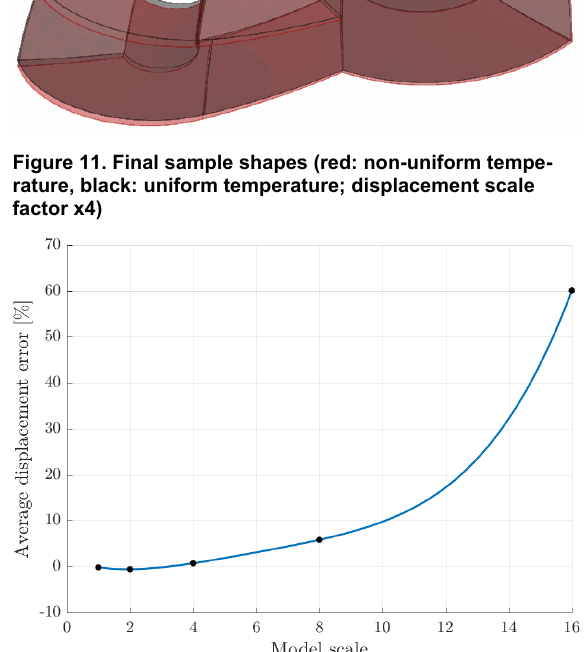
Figure 12. Average final displacement error with respect to model